Question: Name the type of graph shown.
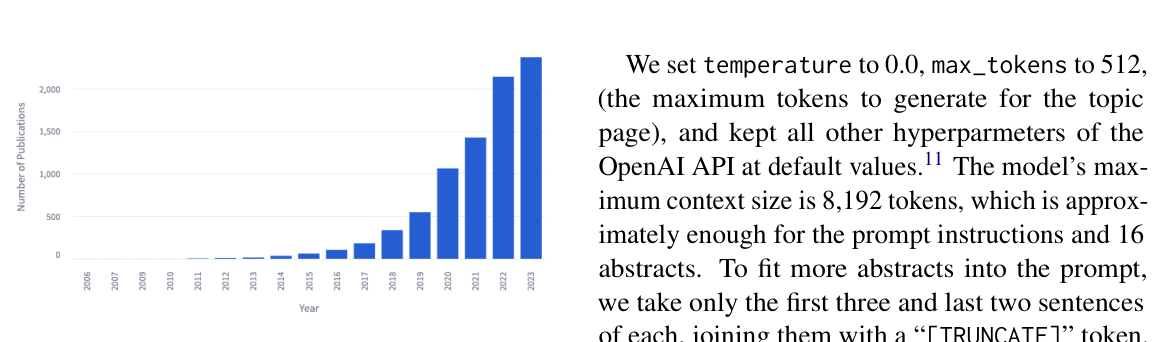
Answer: histogram